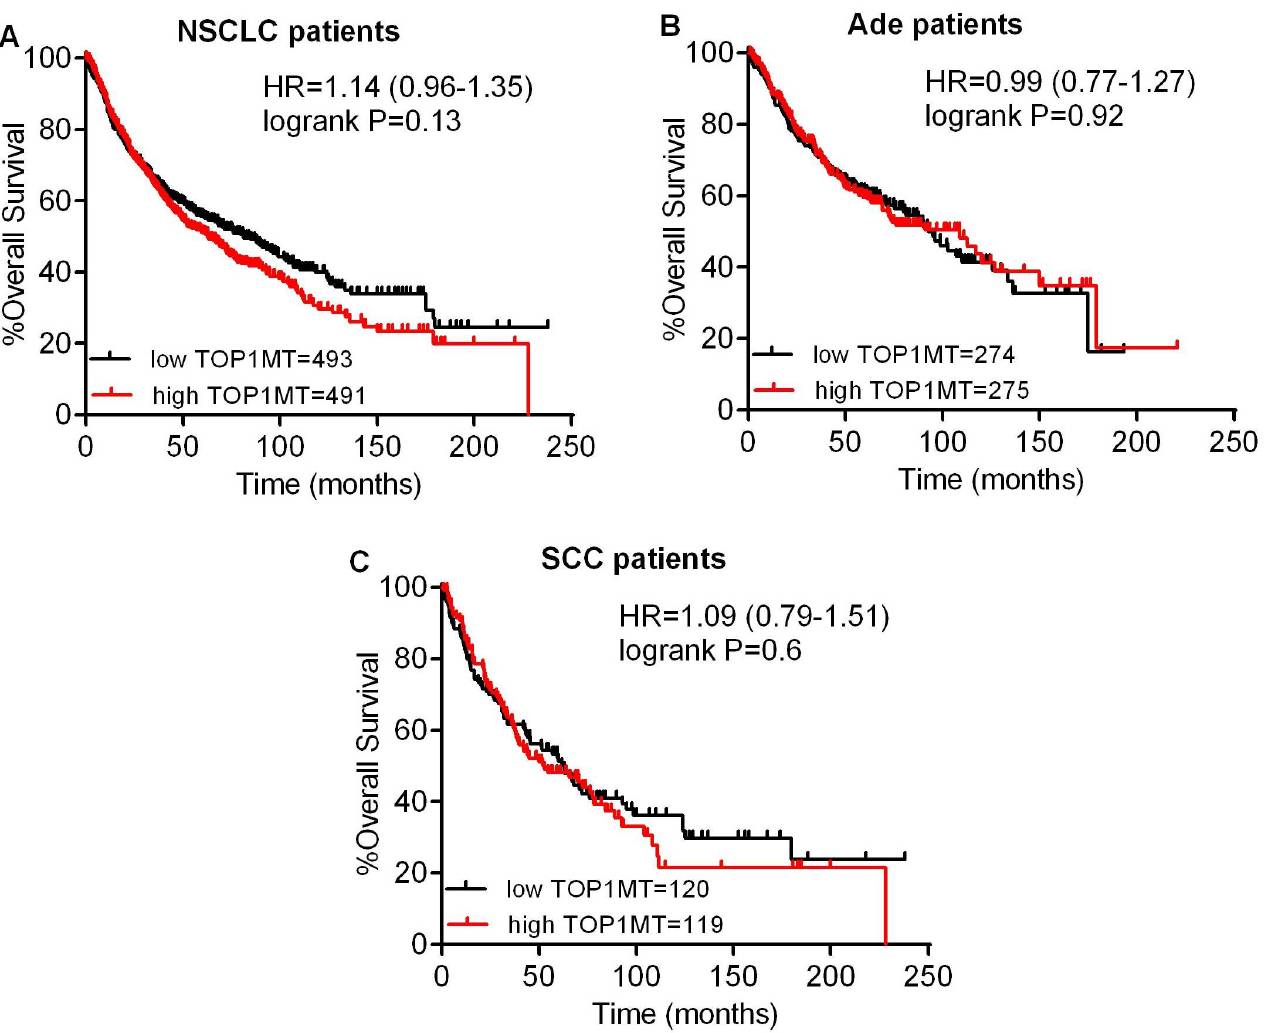
Fig 3. The prognostic value of TOP1MT expression. (A) Survivalcurves were plotted for all NSCLC patients (n = 984). (B) Survival curves were plotted for Ade patients (n = 549). (C) Survivalcurves were plotted for SCC patients (n = 239). Data was analyzedusing Kaplan-Meier Plotter. Patients with expressionabovethe median are indicatedin red line, and patients with expressions below the medianin black line. HR means hazard ratio.